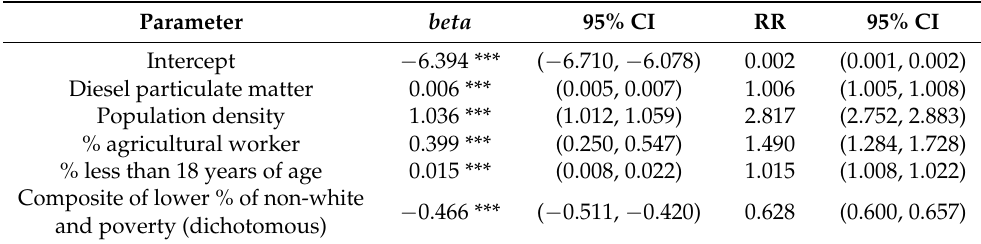
Table 5. Results from Poisson-based multivariate analysis on the counts of acute urticaria for the selected zip codes ( n = 201), San Joaquin Valley, 2016–2017.